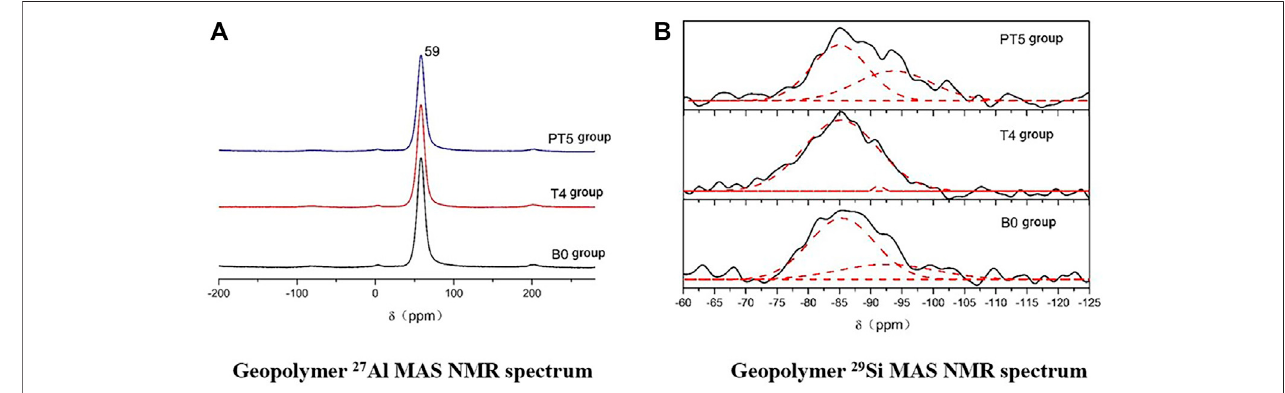
FIGURE 8 | Geopolymer MAS NMR